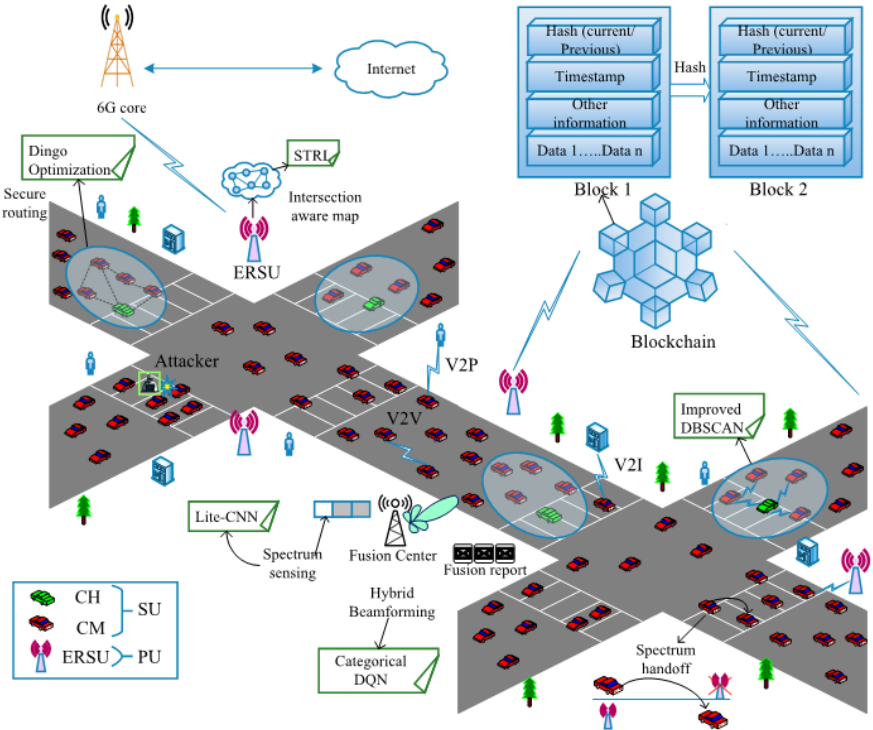
Figure 2. 6GCRN-IoCV system